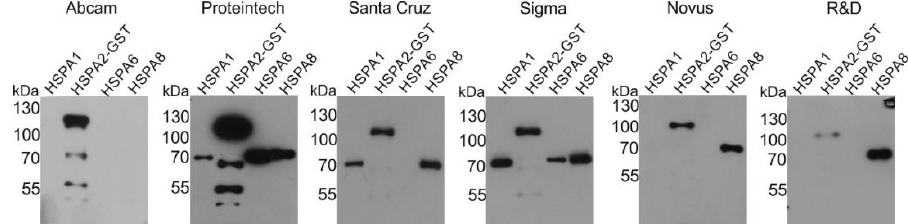
Figure 1. Reactivity of six commercial anti-HSPA2 antibodies to di ff erent recombinant HSPAs. Immunoblots show binding of commercial anti-HSPA2 antibodies to recombinant HSPA1 (69.92 kDa),